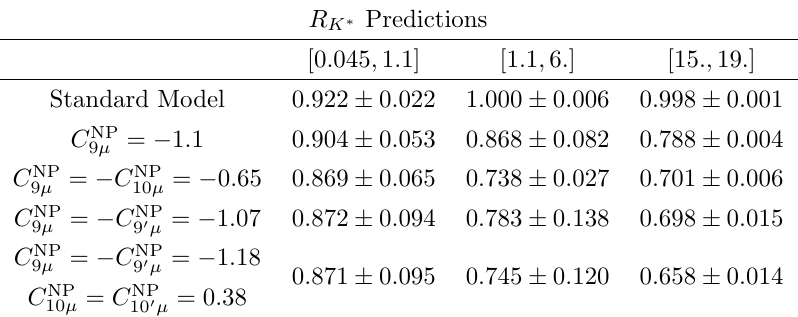
= B in the SM and various NP scenarios. B ! K (cid:3) (cid:22) + (cid:22) (cid:0) B ! K (cid:3) e + e (cid:0)